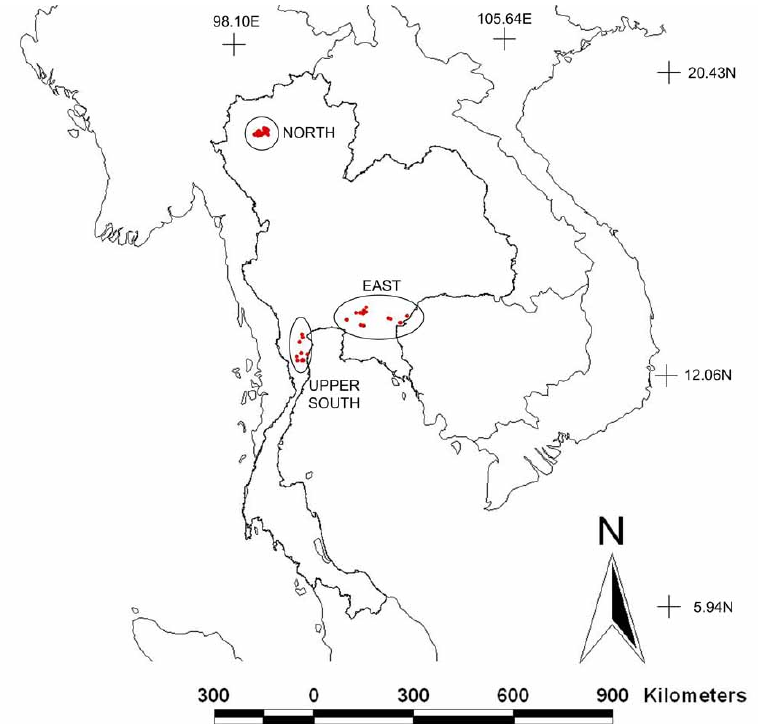
Figure 1. Thailand–the three validation test sites of MODIS hotspots in 2007 are circled.